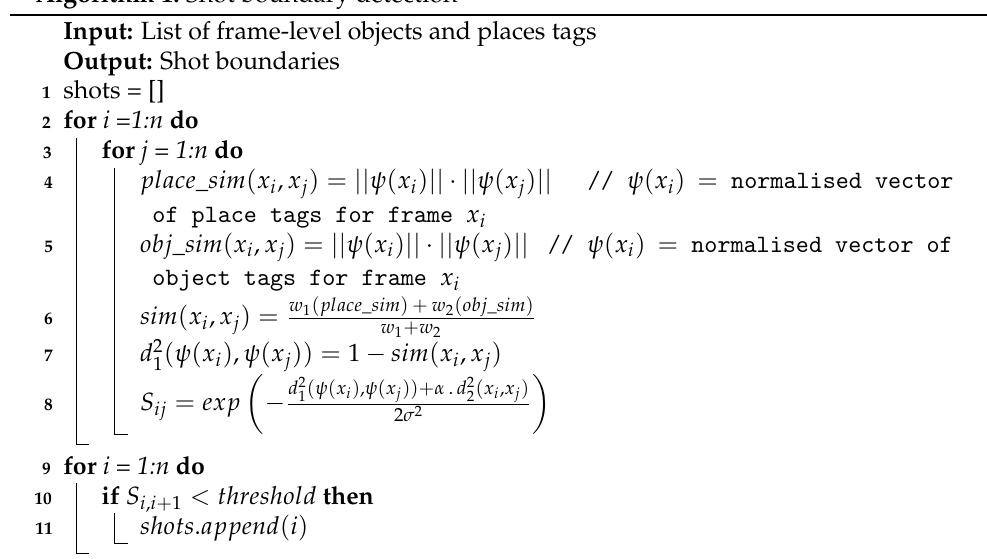
Algorithm 1: Shot boundary